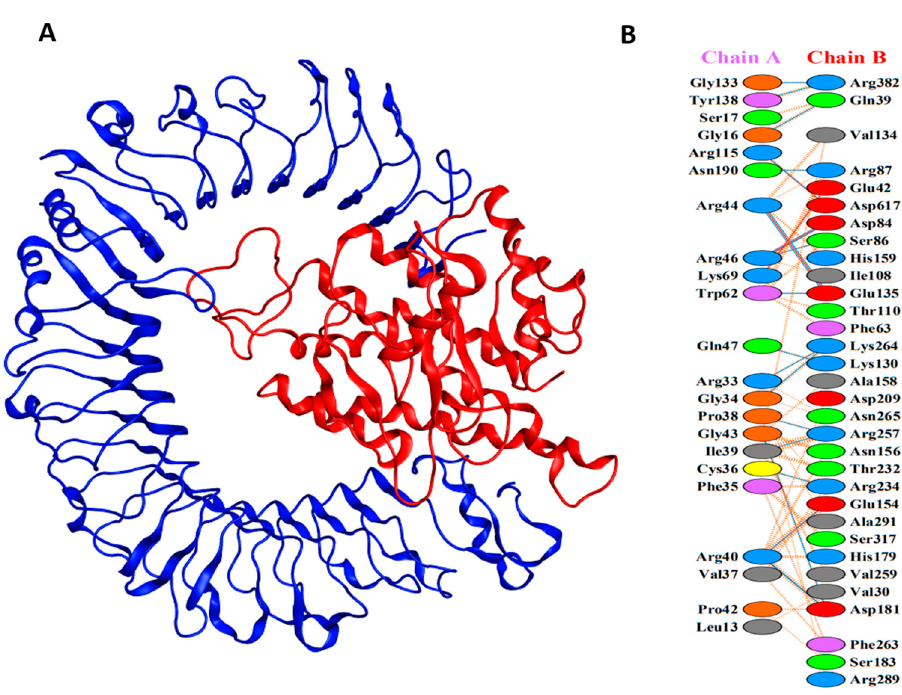
Figure 4. ( A ) The docked complex of LSDV-V2. TLR4 immune receptor is shown in blue while red represents the LSDV-V2 vaccine construct. ( B ) Interacting residues between TLR4 (chain A) and vac- cine construct (chain B).